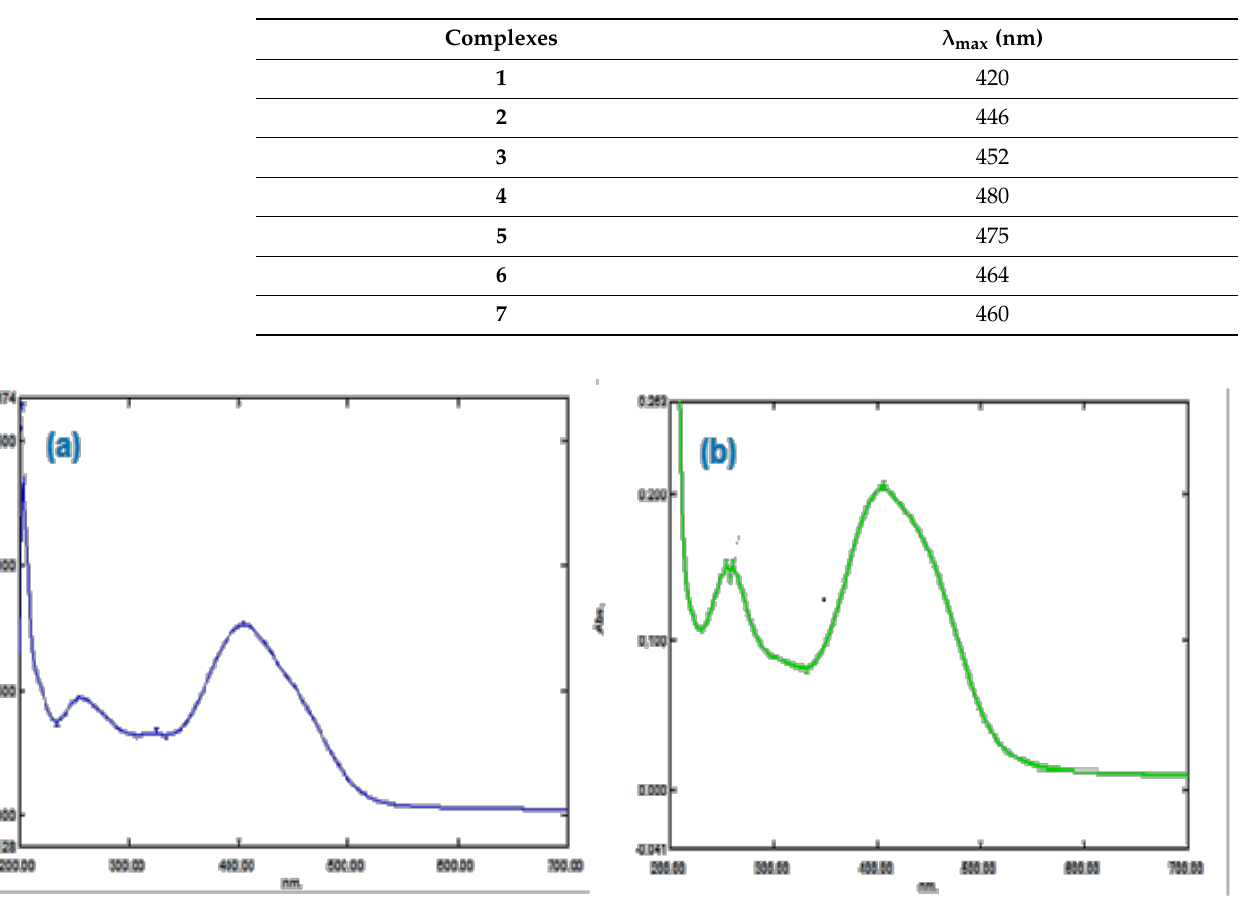
Figure 1. UV–Visible spectra complexes of the complexes ( a ) [Pt(BPT)(dppe)], and ( b ) [Pt(BPT)(dppb)].